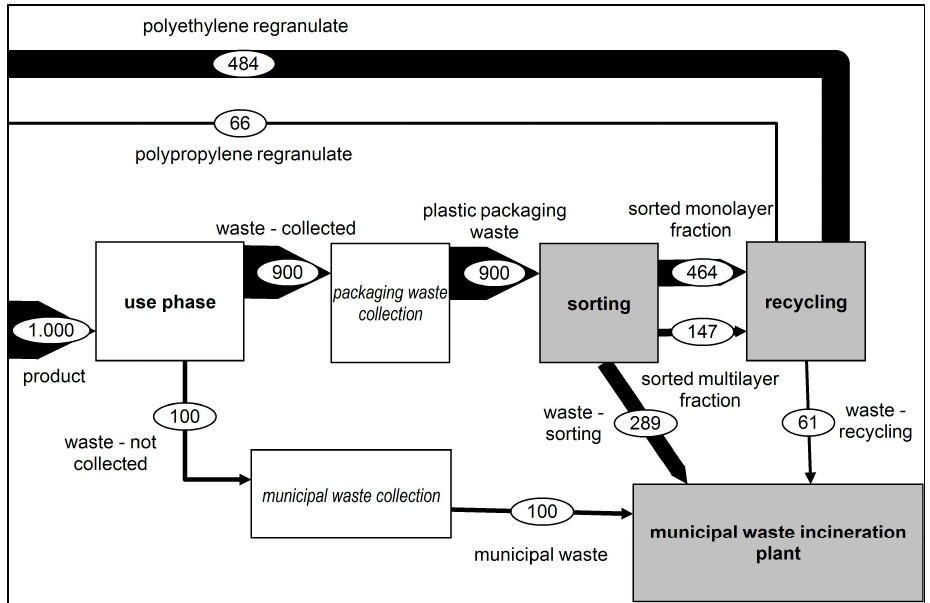
Figure 8. Representation of the material flows—2030 scenario.